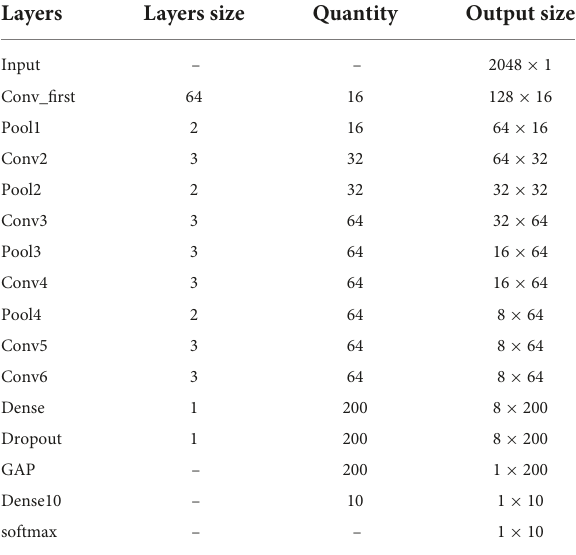
TABLE 1 Model structure parameters.